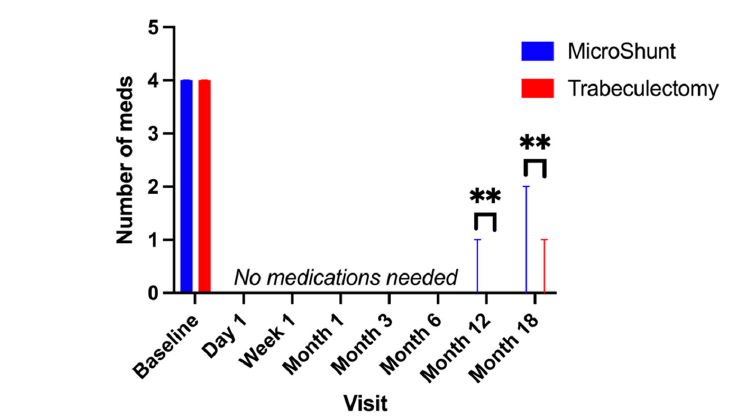
Figure 2. Changes in the median number of glaucoma medications during follow-up after MicroShunt and trabeculectomy (** denotes p ≤ 0.010 between groups, assessed using Mann–Whitney U tests). Error bars represent interquartile ranges.